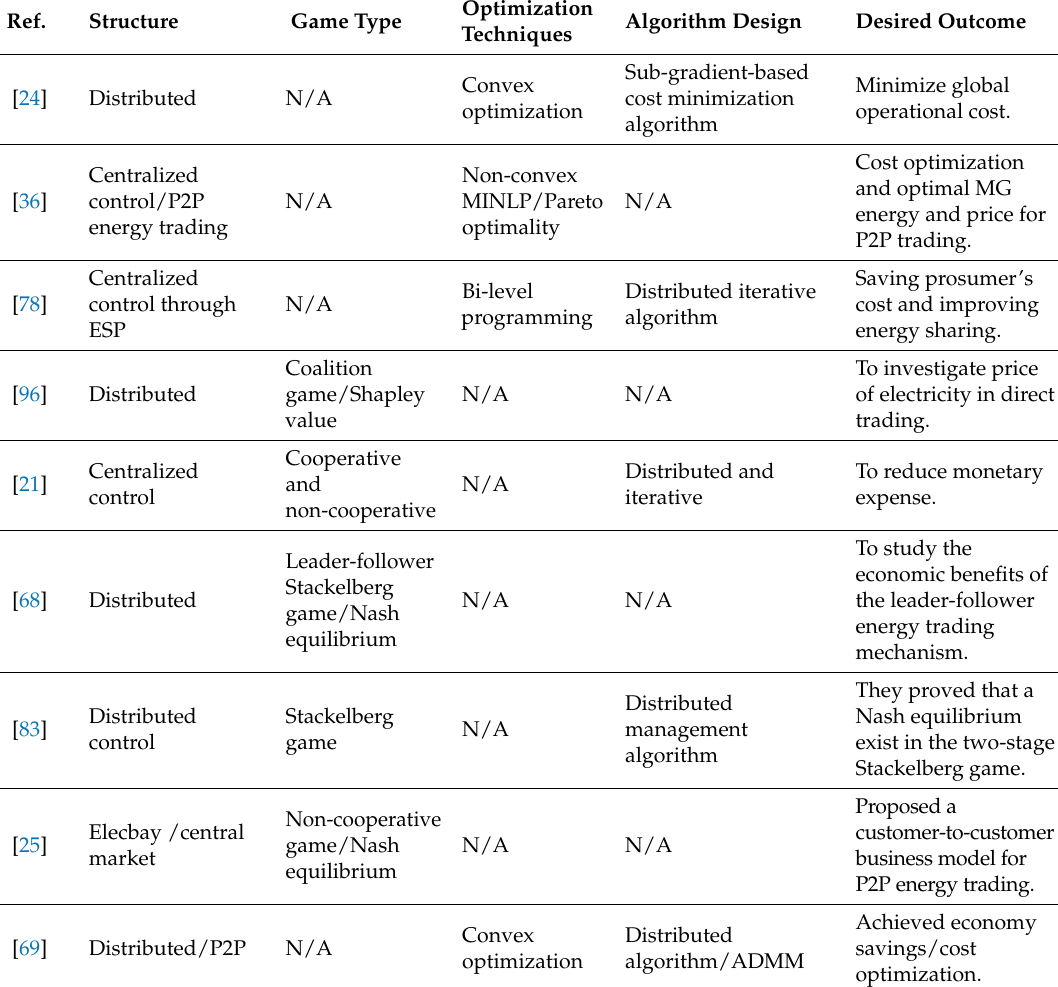
Table 2. Required framework and desired outcome for TE. ESP: energy sharing provider; ADMM: alternating direction method of multipliers. P2P: peer-to-peer; ESP: energy sharing provider; MINLP: mixed integer non-linear programming; MG: